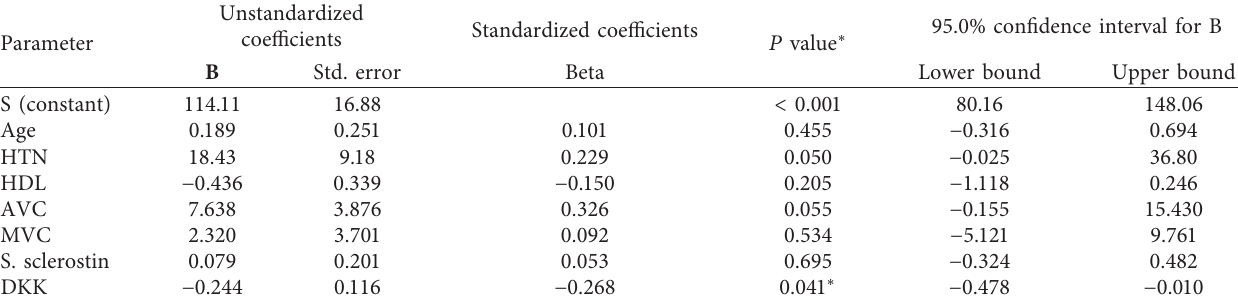
Table 6: Linear regression analysis of LMV/BSA with some parameters among the studied subgroups. Parameter